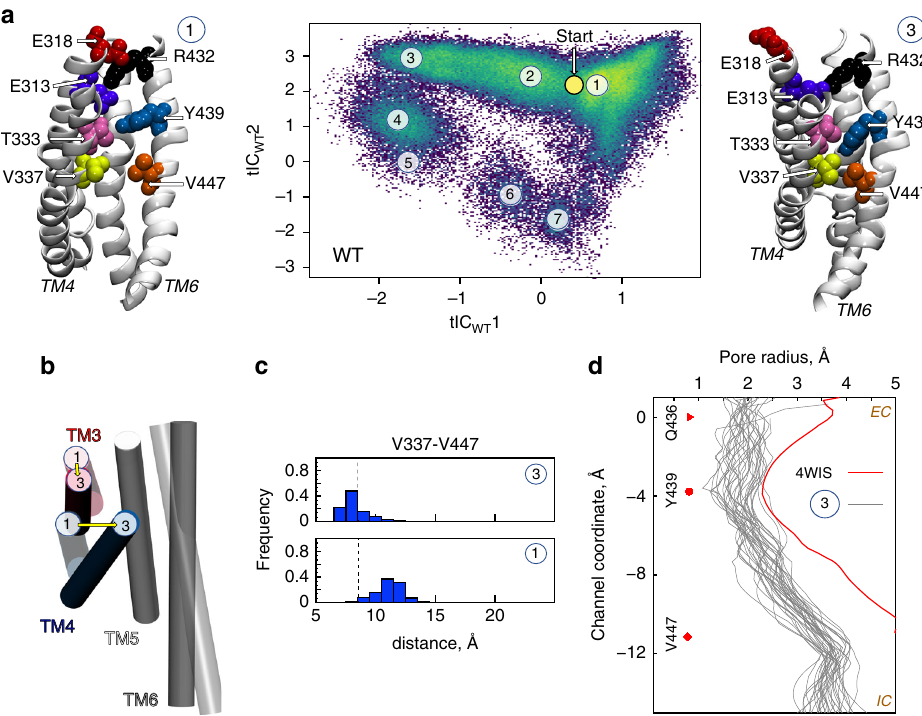
Fig. 1 Structural characteristics of states in the lipid translocation mechanism. a Central panel: 2-D landscape representing all the trajectories of the WT nhTMEM16 (Supplementary Table 1) mapped with the tICA transformation in the space of the fi rst two tICA eigenvectors (tIC WT 1 and tIC WT 2; see “ Methods ” ). The lighter shades (green to yellow) indicate the most populated regions of the 2D space. The dynamics of the two subunits of the protein in each trajectory were analyzed separately. Microstates representing the most populated states in these simulations are indicated by the numbered circles and represent various stages in the lipid translocation process. Representative structures of microstates 1 and 3 are shown in the surrounding snapshots. In these models, TM4 and TM6 are labeled; the relevant groove residues appear in space- fi ll representations and are labeled (see also Supplementary Fig. 1A). The location of the initial conformation of the system (the 4WIS model) is indicated by the yellow circle marked Start. b Structural comparison of the position of groove helices TM3-TM6 (in cartoon) in microstates 1 and 3. Note the major repositioning of TMs 3 and 4 from microstate 1 (light gray) to microstate 3 (dark gray). c The probability distributions of the C α -C α distance between V337 and V447 residues in the ensemble of conformations from microstates 1 and 3. The vertical dashed lines represent the 8.5 Å distance cut-off used to de fi ne the occluded conformation of the groove. d The pore radius as a function of position along an axis perpendicular to the membrane (channel coordinate) for the X-ray structure of nhTMEM16 (PDBID 4WIS, red line), and for selected structures from microstate 3 (gray lines) representing 34 frames (separated from each other by at least 10 ns time interval) from the last 500 ns of a 15 μ s MD simulation (WT6 in Supplementary Table 1). The EC and IC ends of the pore are indicated; Z = 0 Å corresponds to the location of the C α atom of residue Q436 (red triangle symbol), the dot marks the position of the C α atoms of residue Y439, and the diamond symbol that of V447. The calculations were performed with HOLE